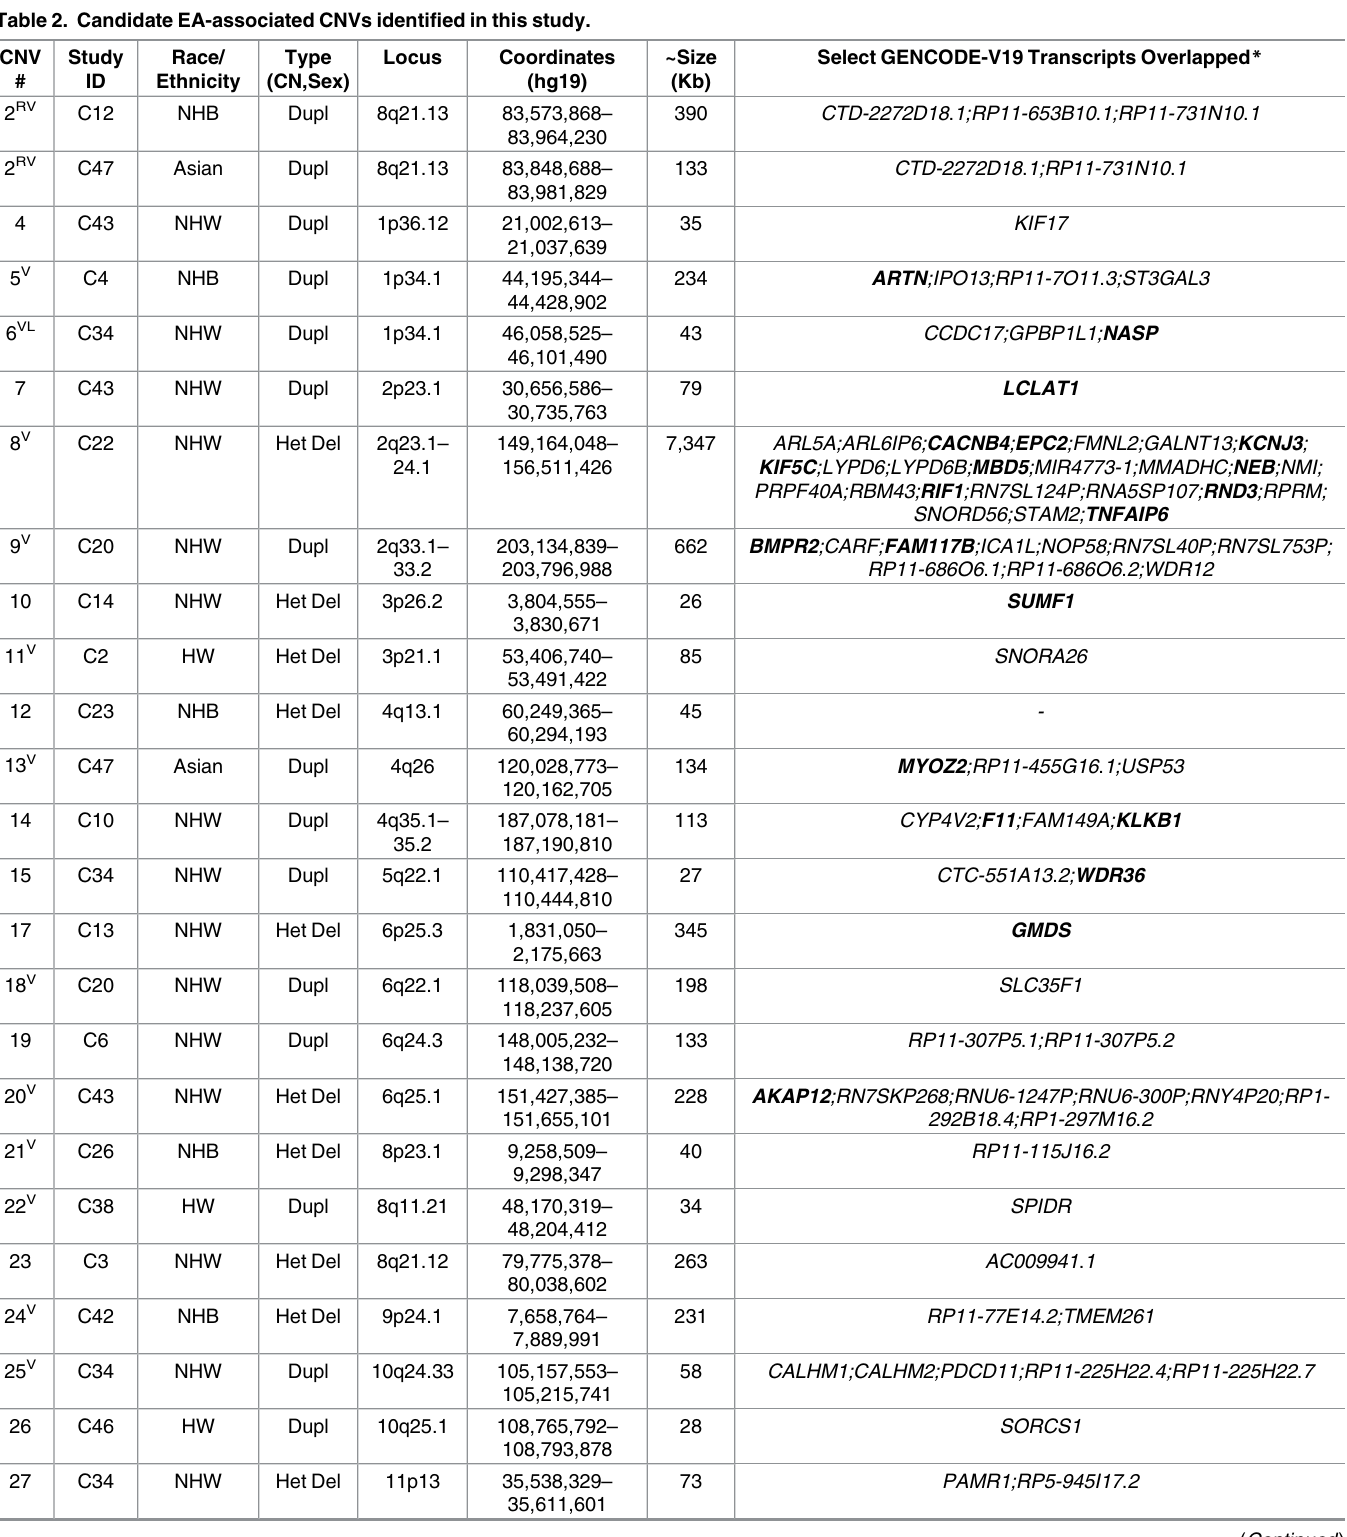
Table 2. Candidate EA-associated CNVs identified in this